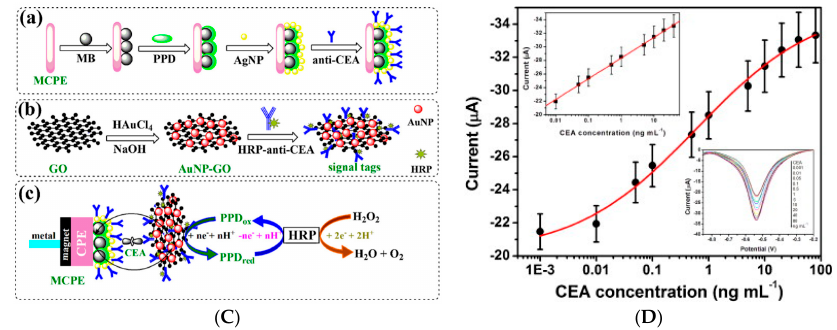
Figure 26. ( A ) Sandwich immunodetection of PSA using Ab1-Au@MNPs, magnetic collection and enzymatic transduction; ( B ) Calibration plots of reduction current versus PSA concentration using planar Ab 1 -modified gold electrode (black dots) and Ab 1 -Au@MNPs (black dots), anti-biotin immobilised on thioctic acid modified Au@MNPs (red squares) and thioctic acid modified Au@MNPs exposed to Ab 1 without EDC/NHS activation (blue triangles). Reproduced from [146] with permission from The Royal Society of Chemistry. ( C ) Steps required for ( a ) the magnetic capture of PSA using Ab 1 -Au@MNPs; ( b ) construction of the GO-based label; and ( c ) sandwich immunodetection of CEA; ( D ) Calibration plots of the magnetic immunoassay toward CEA standards in pH 5.3 acetic acid salt-buffered saline buffer + 3.0 mM H 2 O 2 . Inset: corresponding linear and DPV